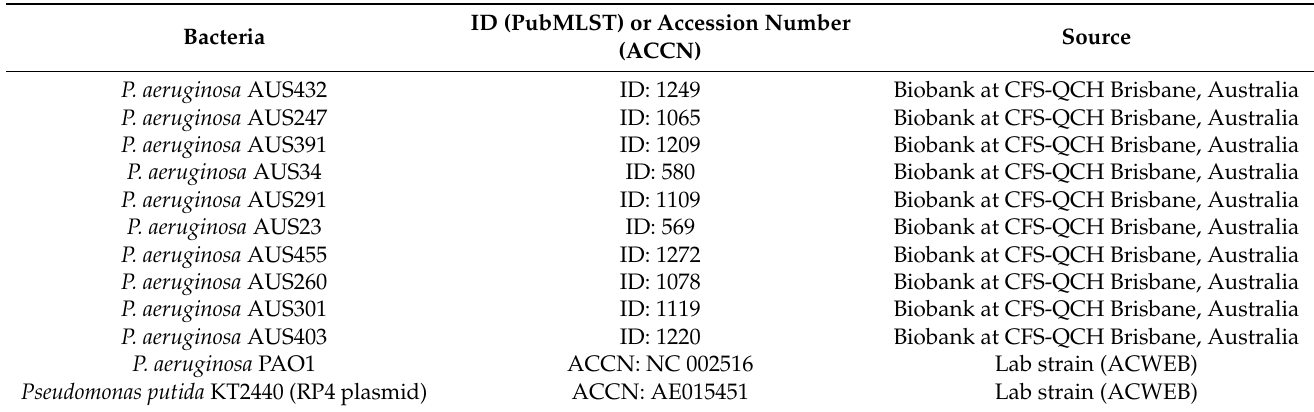
Table 2. Bacterial strains used for host range